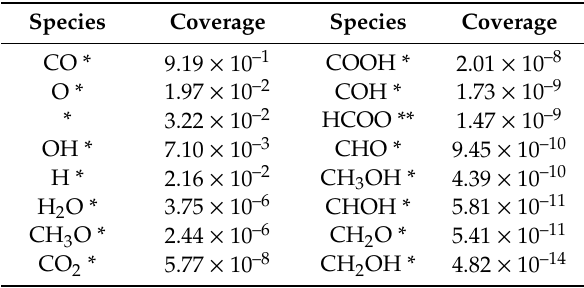
Table 3. Coverages of surface species for a representative operating condition of